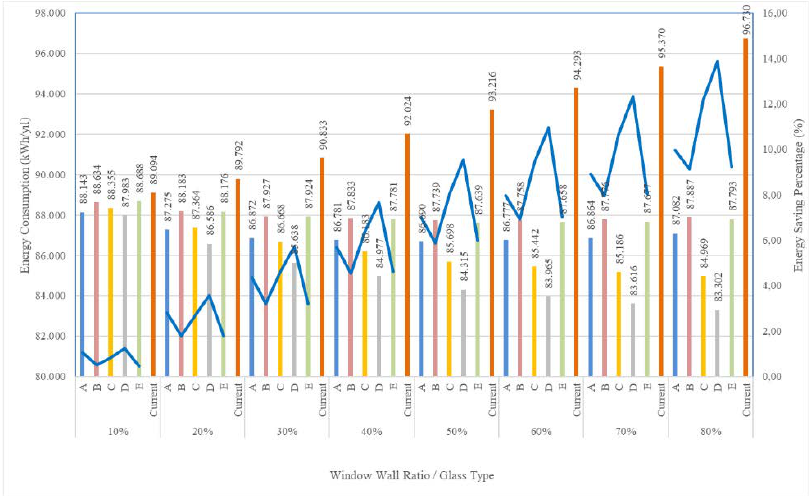
Figure 11 Energy saving rates, calculated energy consumptions and reference energy consumptions for West